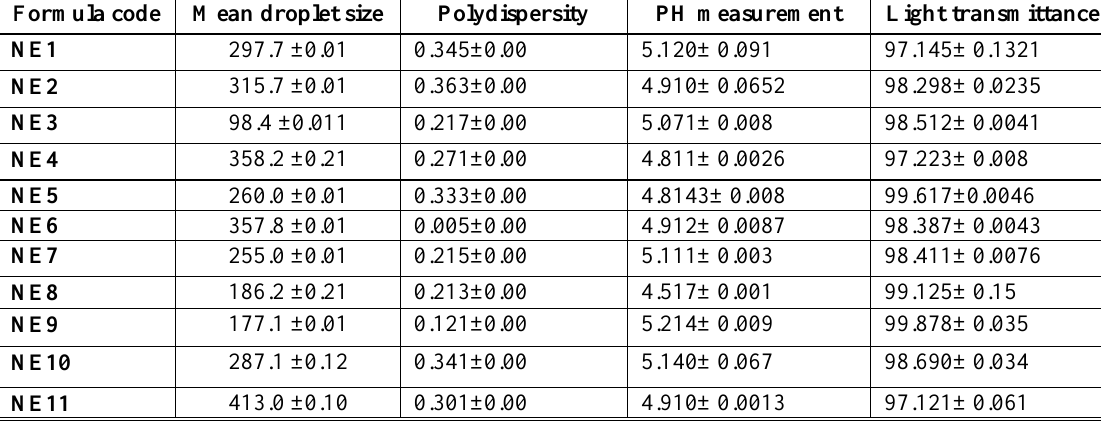
Table 5. Characterization